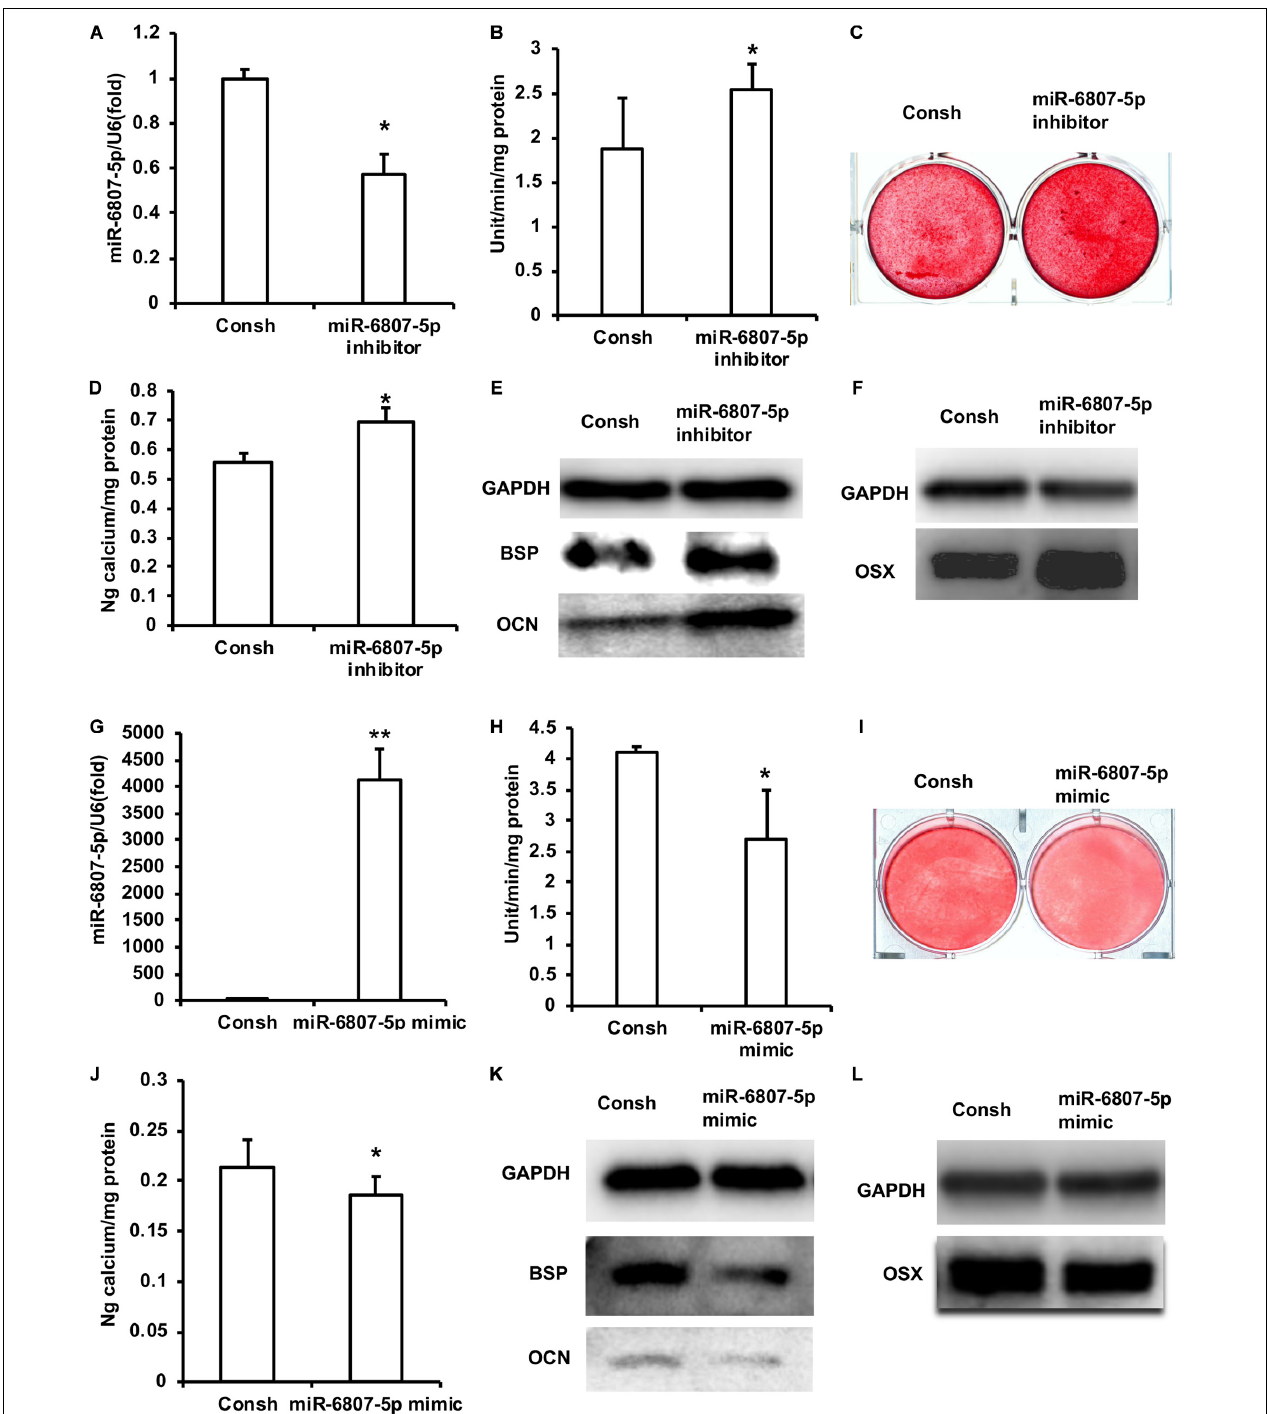
FIGURE 1 | miR-6807-5p inhibited the odontogenic differentiation of DPSCs. (A) The expression of miR-6807-5p was detected by real-time RT-PCR. (B) ALP activity after 5 days of mineralized induction. (C,D) ARS and Calcium ion quantification results after 2 weeks of mineralized induction. (E) After 1 week of mineralized induction, the expressions of BSP and OCN were detected by western blot. (F) The expression of OSX was detected by western blot. (G) The expression of miR-6807-5p was detected by real-time RT-PCR. (H) ALP activity after 5 days of induction. (I,J) ARS and calcium ion quantitative results after 2 weeks of induction. (K) After 1 week of induction, the expressions of BSP and OCN were detected by western blot. (L) The expression of OSX was detected by western blot. GAPDH was used as internal control. Student’s t -test was performed to determine statistical significance. All error bars represent the standard deviation ( n = 3). * p ≤ 0.05, ** p ≤